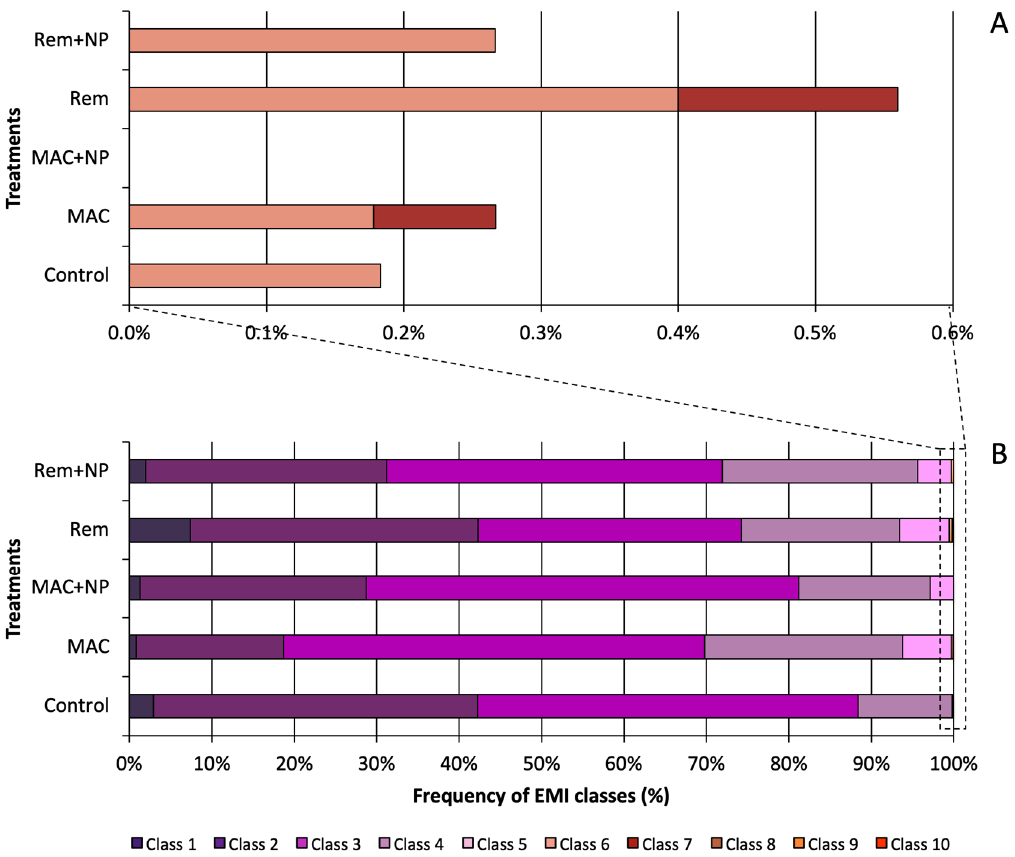
Figure 2. Erythrocytic maturity index (EMI) in S. maximus exposed to different metallic mixtures, with and without nanoparticles, for 7 consecutive days. ( A ) Mean values for the frequency (%) of cells observed in each maturity class (maturity decreases from class 1 to class 7) are represented. ( B ) Detailed representation of the frequency (%) of EMI classes 6 and 7. MAC—maximum concen- trations allowable for effluents discharges; Rem—MAC concentrations after remediation processes; MAC + NP—maximum concentrations allowable for effluent discharges plus Ag-NP and Au-NP; Rem + NP—MAC concentrations after remediation processes plus Ag-NP and Au-NP.